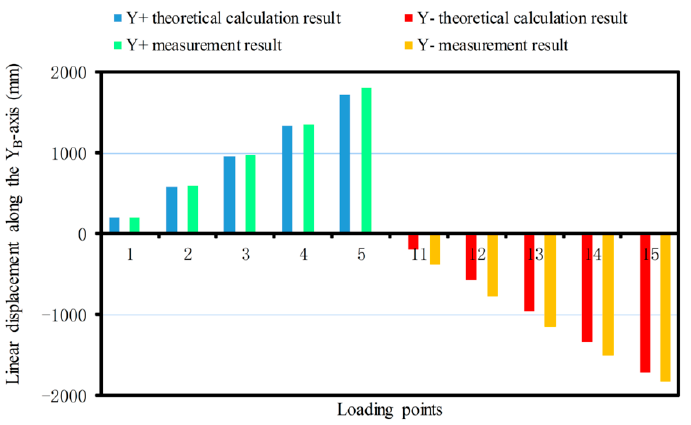
Y -axis. B Y -axis. Y -axis. B B